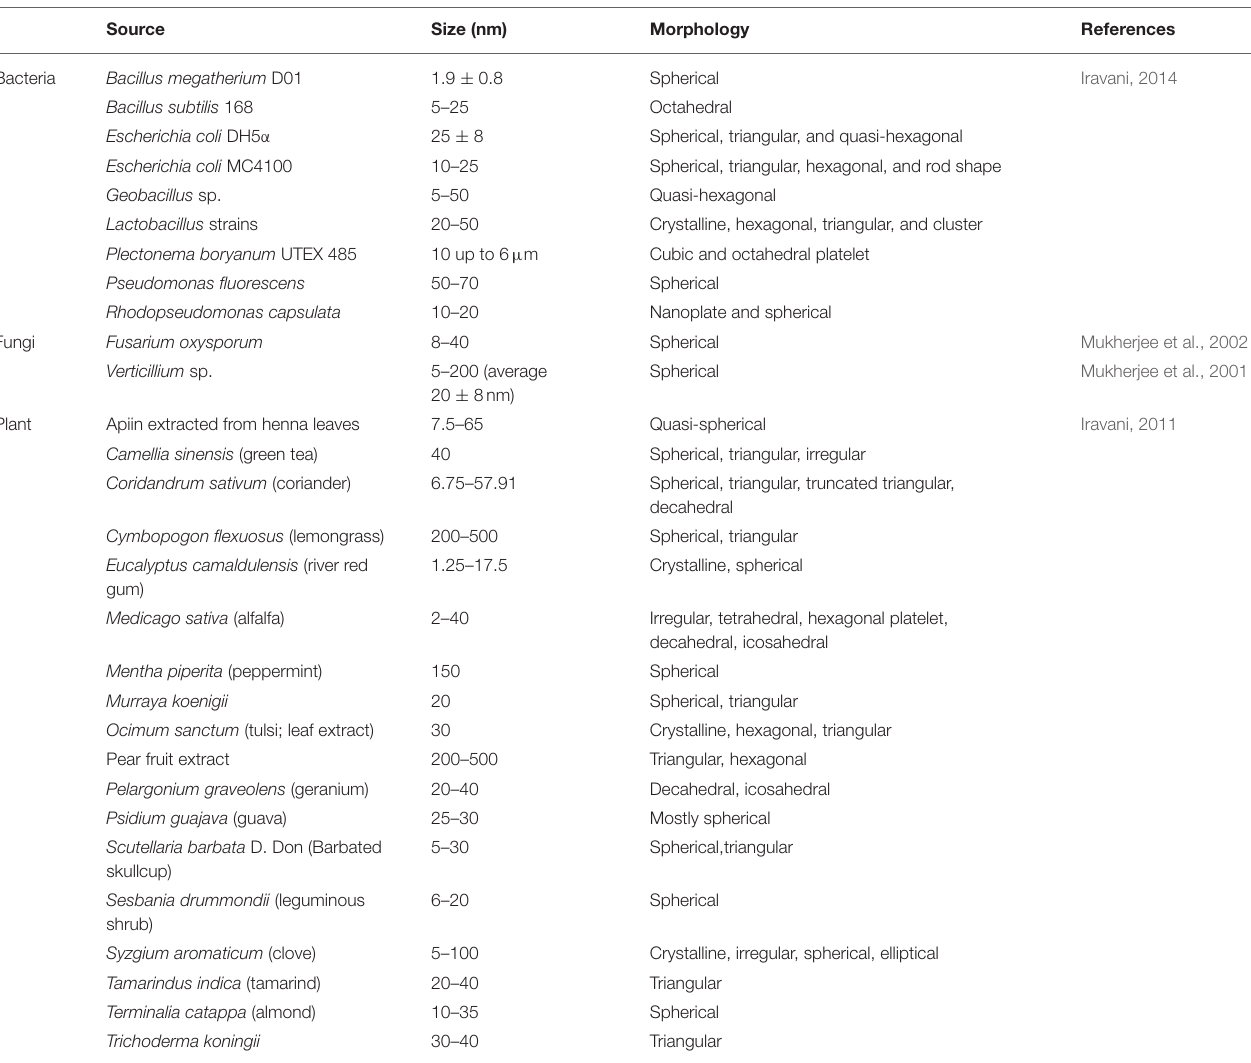
TABLE 1 | Green chemistry for gold nanoparticle